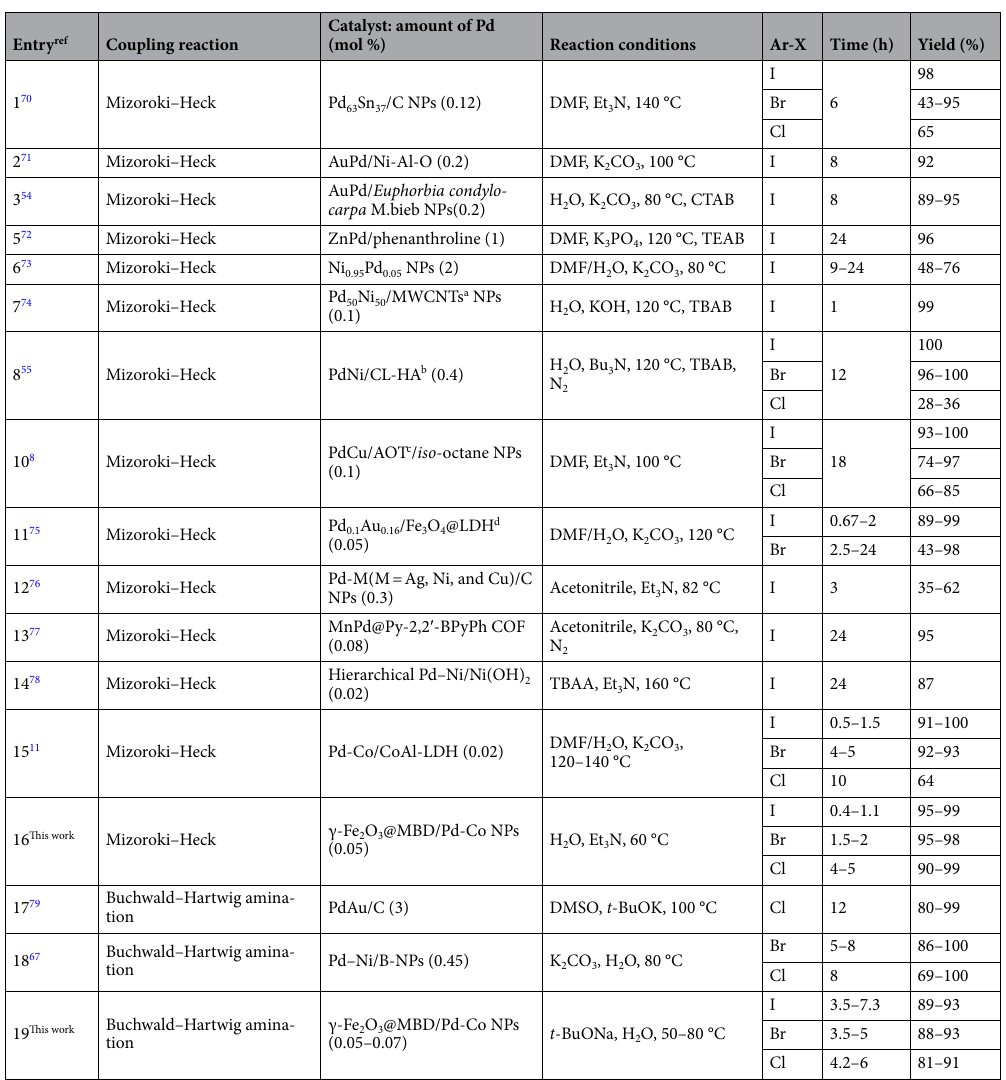
Table 7. Comparison of catalytic activities of our catalyst with various reported bimetallic Pd catalysts for Mizoroki–Heck and Buchwald–Hartwig amination reactions. [a] Multi-walled carbon nanotube, [b] humic acids, [c] aerosol-OT, [d] layered double